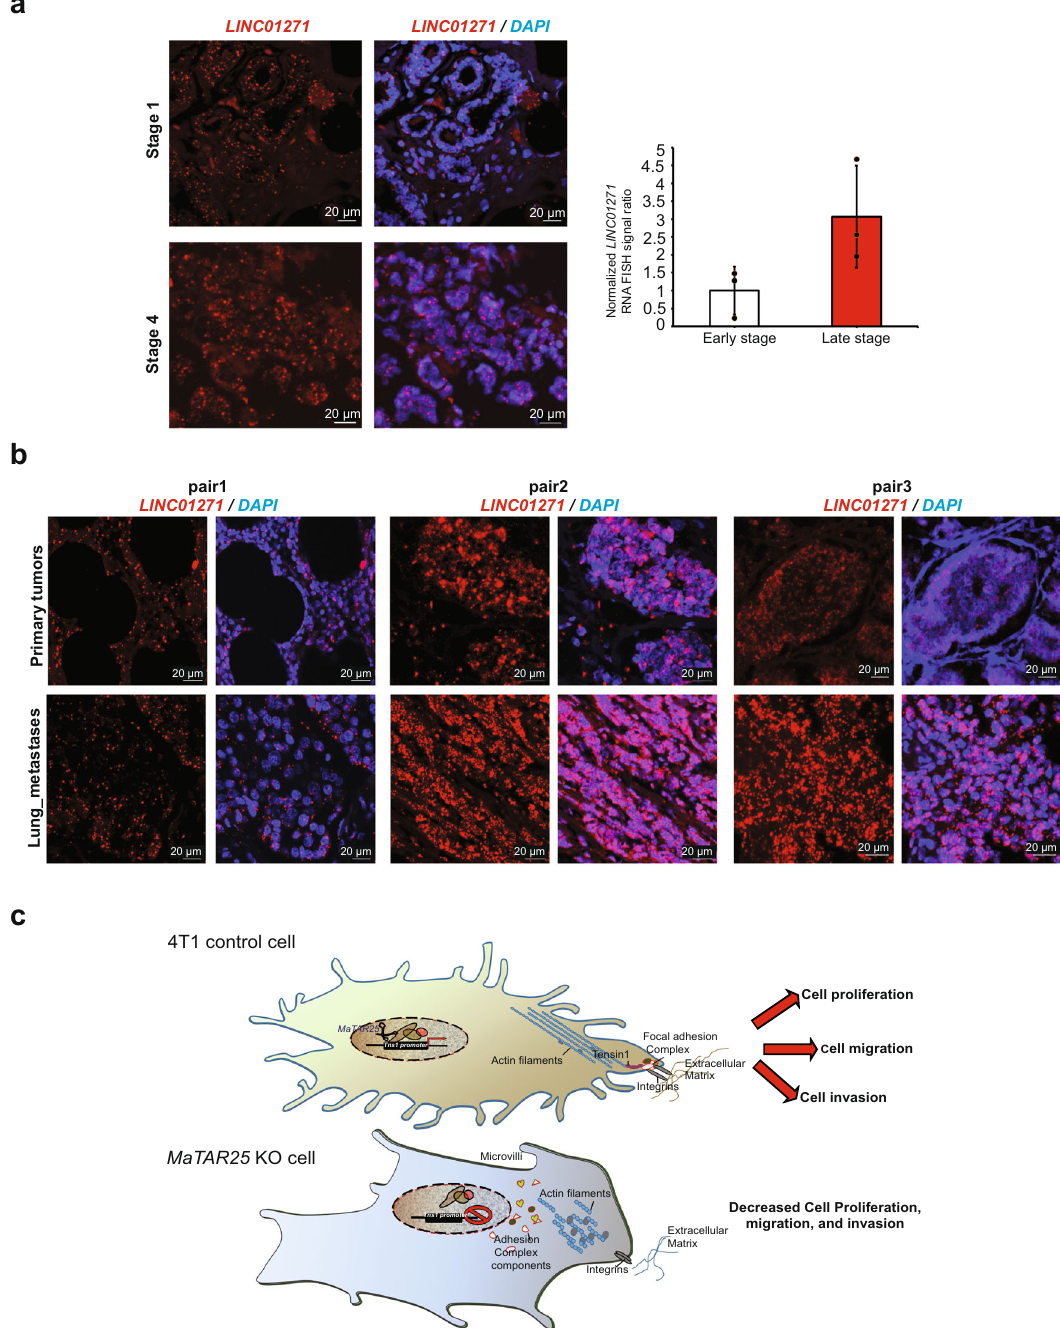
Fig. 7 LINC01271 expression in breast tumors and lung metastases. a smRNA-FISH images showing the expression of LINC01271 (red) in patient breast tumor sections from different stages of breast cancer. More than six random areas on each slide were examined, and representative images are shown. Scale bars are 20 μ m. The quanti fi cation of six images (three early stage and three late stage) of breast tumor sections is shown and data are presented as mean values ± SD. P = 0.08587 (paired Student ’ s t test; two-tailed). b smRNA-FISH images showing the expression pattern of LINC01271 (red) within luminal subtype patient breast cancer primary tumors and lung metastases sections from the same patients. More than six random areas on each slide were examined, and representative images are shown. Scale bars are 20 μ m. c Proposed model of MaTAR25 function. MaTAR25 acts as a scaffold and/or chaperone recruiting PURB to the Tns1 gene where it induces its transcription. The Tns1 protein associates with focal adhesion complexes regulating signaling between the extracellular matrix and the actin cytoskeleton. KO or KD of MaTAR25 results in a reorganization of the actin cytoskeleton and focal adhesion complexes as well as a signi fi cant decrease in microvilli resulting in a reduction in cell proliferation and